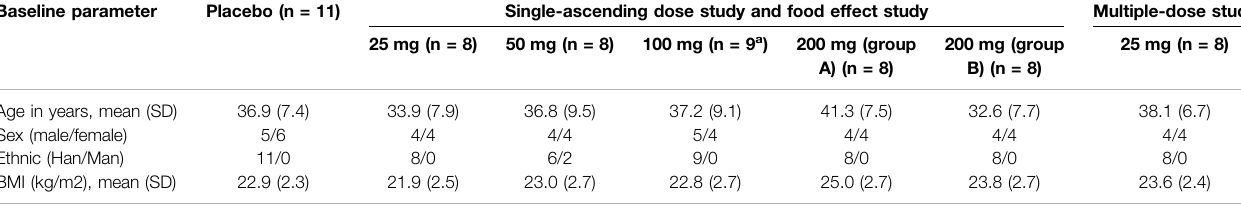
TABLE 1 | Demographic characteristics of participants. Baseline parameter Placebo (n = 11) Single-ascending dose study and food effect study Multiple-dose